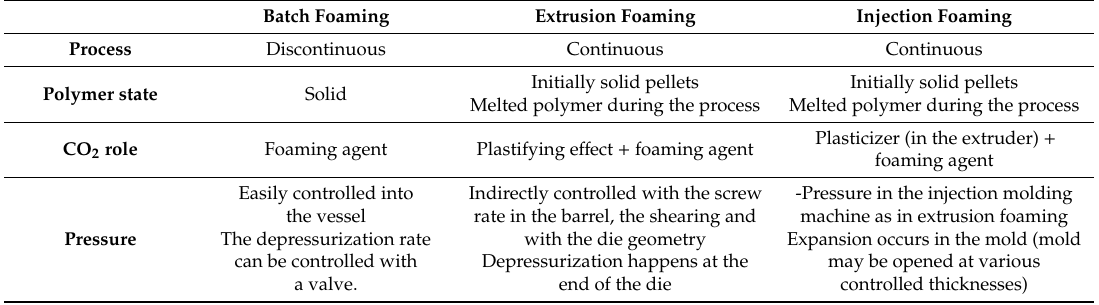
Table 2. List of influencing parameters on polymer CO 2 foaming in batch vs. extrusion /